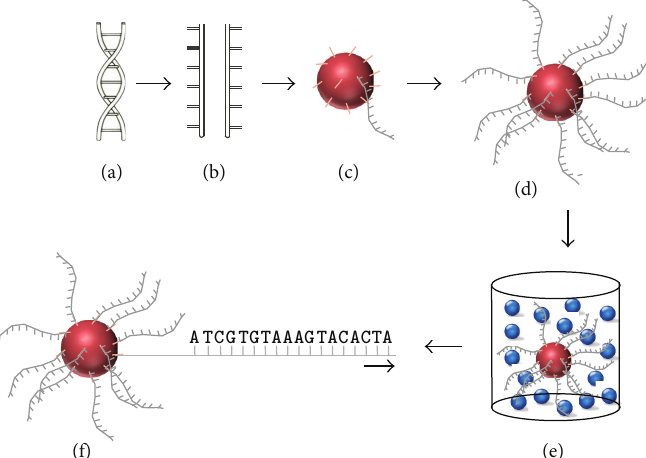
F 1: Schematic representation of the principles of massive parallel sequencing using beads. Double-stranded DNA (a) is fragmented into single-stranded DNA (b) which is subsequently coupled, via adaptors, to agarose beads by oligonucleotides complementary to the adaptor (c). ese beads are submerged in an emulsion where ampli�cation of the single DNA fragment occurs (d). Subsequently, the bead is placed into a well (e), already equipped with all reagents for sequencing (small beads). Within these wells, parallel sequencing of the different DNA fragments occurs, resulting in the generation of the genetic code of the fragment